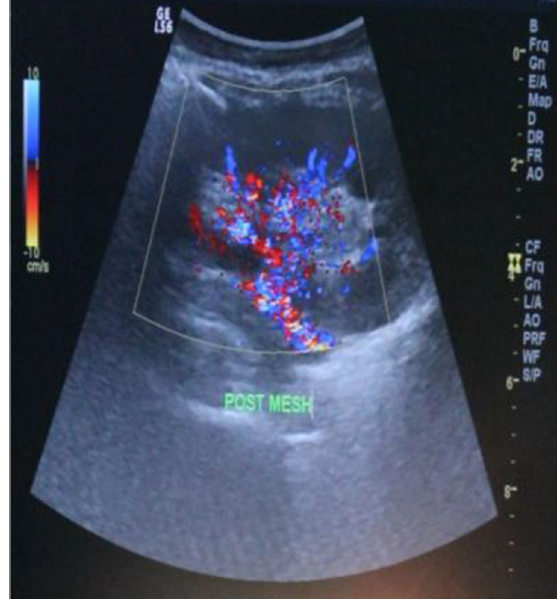
Figure 4. Ultrasound evaluation results of recipient after mesh